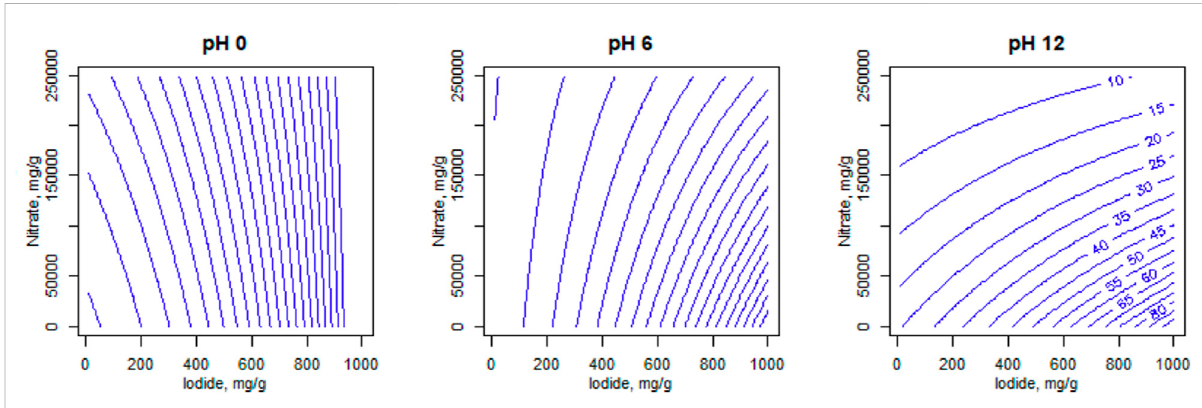
FIGURE 5 Predicted contour plots for S914-Ag at different solution pH values, based on the overall group model. Blue numerical values on contour lines represent predicted iodide